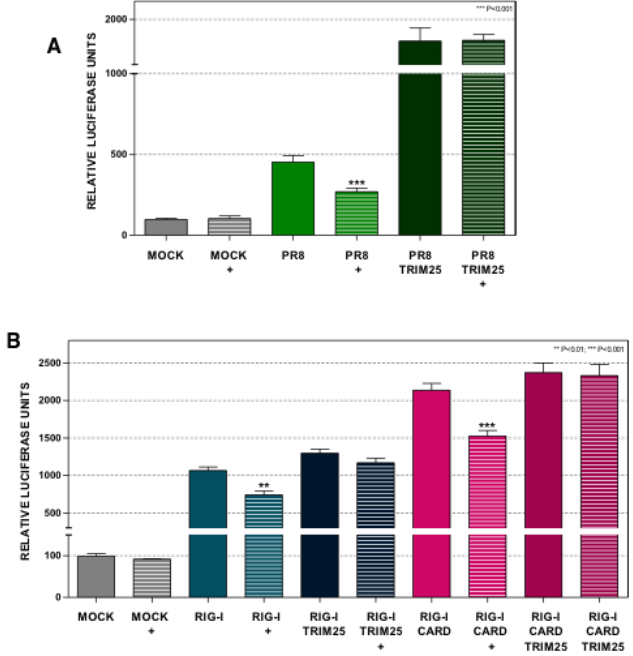
Figure 7. The overexpression of TRIM25 counteracts the effect of Dot1L inhibition on interferon signaling. ( A ) A549 cells were left untreated (MOCK) or treated with 1 μ M EPZ (+) for 48 h. Then the